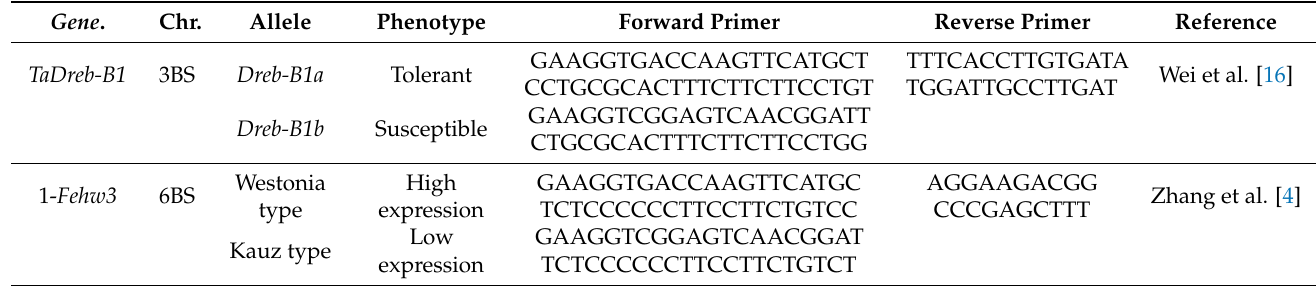
Table 1. Basic information on the KASP primer sequences used in this